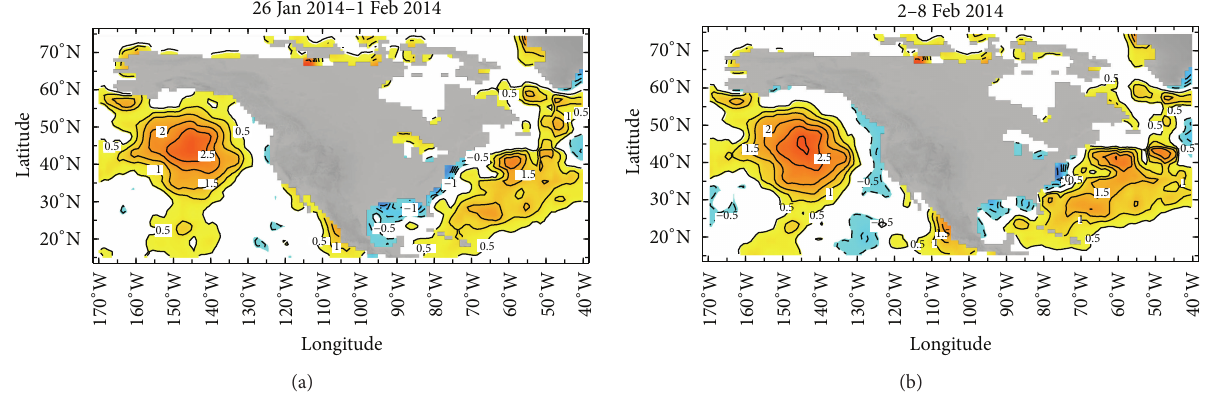
Figure 2: (a) SST anomalies 26 Jan 2014–1 Feb 2014. (b) SST anomalies 2–8 Feb 2014.